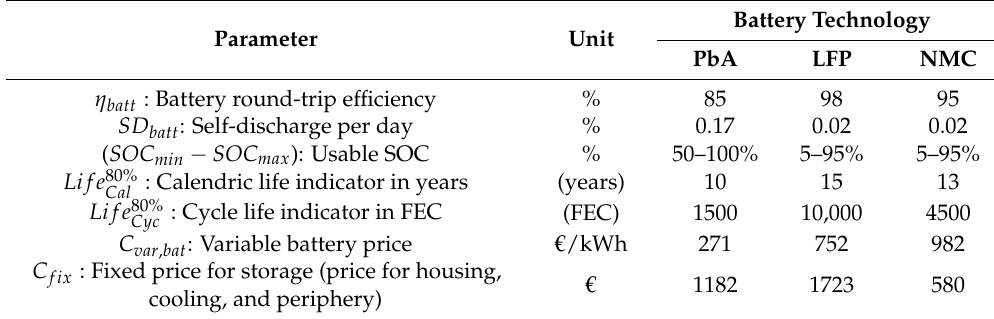
Table 2. Performance parameters of BESS using three different battery technologies. The data was derived from a literature survey (see Appendix A). Terms state of charge (SOC) and full equivalent cycles (FEC) are further explained in the